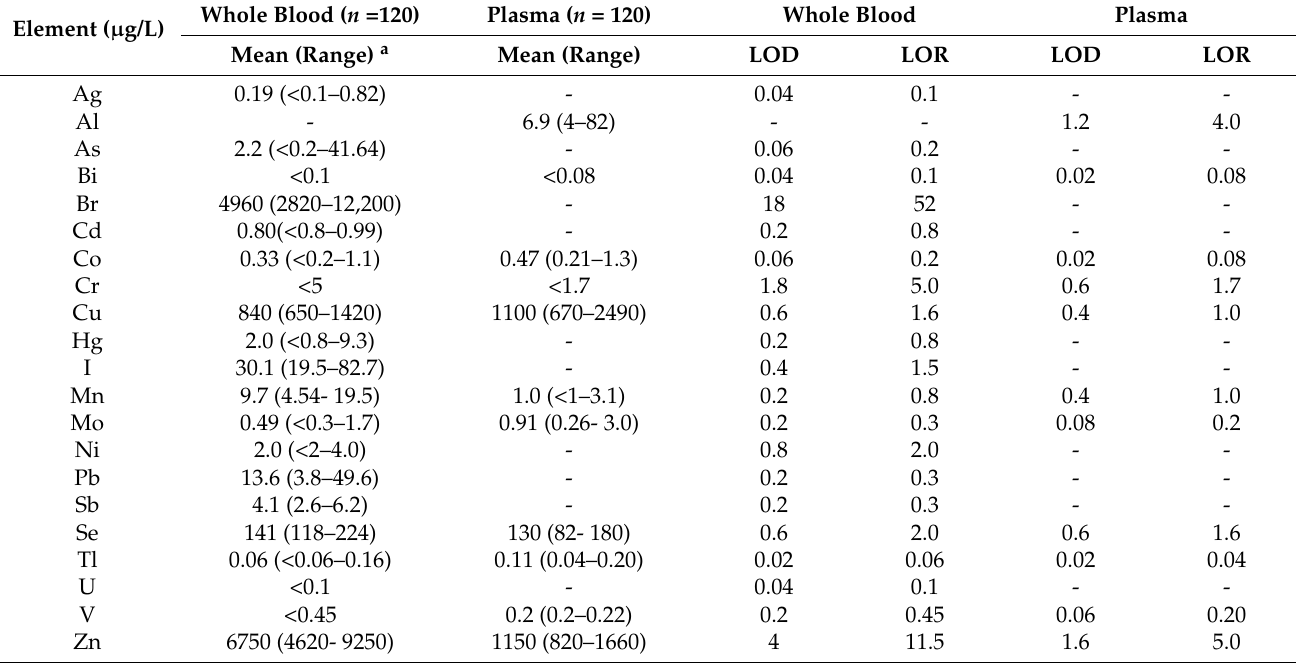
Table 5. The levels of trace elements in whole blood and plasma including method limit of detection (LOD) and limit of reporting (LOR).